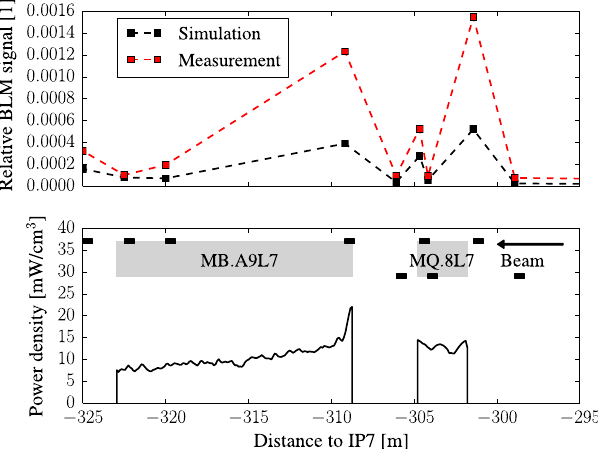
FIG. 17. Up: Local excerpt of the comparison of BLM signals and FLUKA simulation results for ramp 3 of the 2013 collimation quench test, both respectively normalized to the BLM of the skew primary collimator (TCP.B6R7) located at þ 200 m [16,60]. Down: Longitudinal pattern of the power density (averaged over the inner coil radial thickness) at the transition between cells 8 and 9.